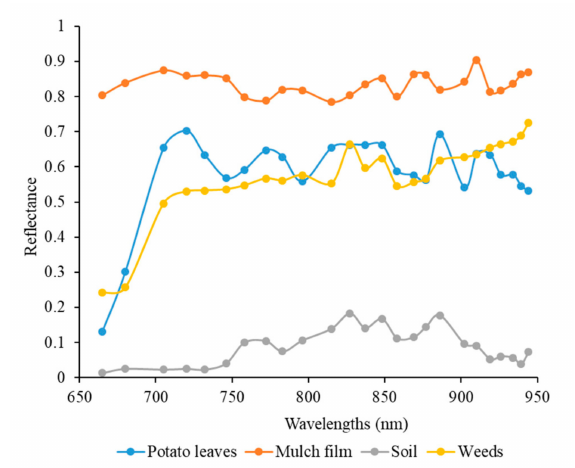
Figure 9. Reflectance of potato leaves, mulch film, soil and weeds at 25 wavelengths.